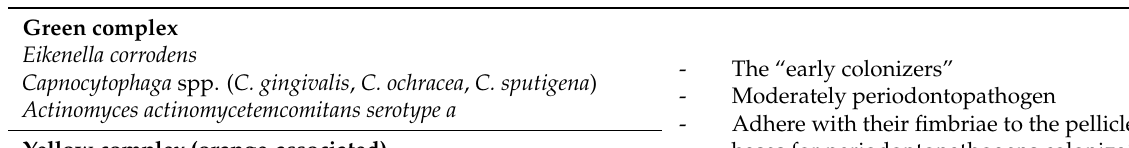
Table 1. The periodontopathogen potential of each bacterial complex of the subgingival plaque, according to Socransky et al., 1998